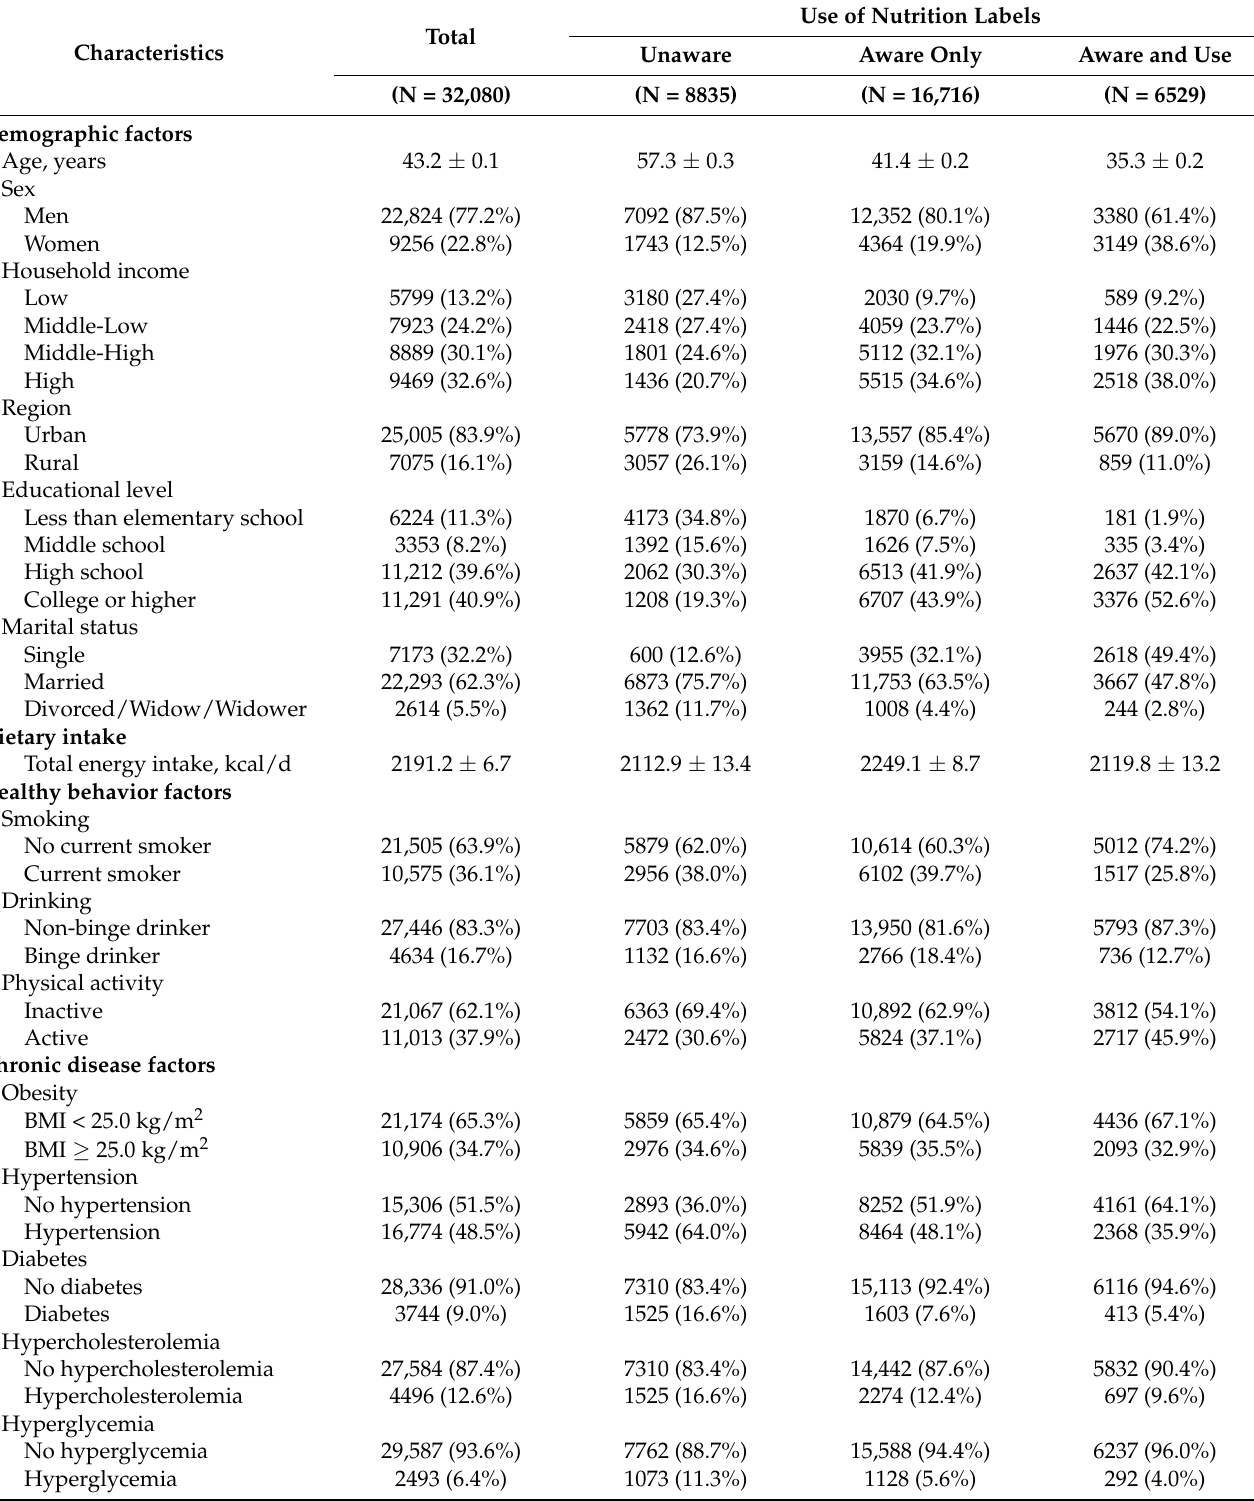
Table 1. Characteristics # of study participants (N =